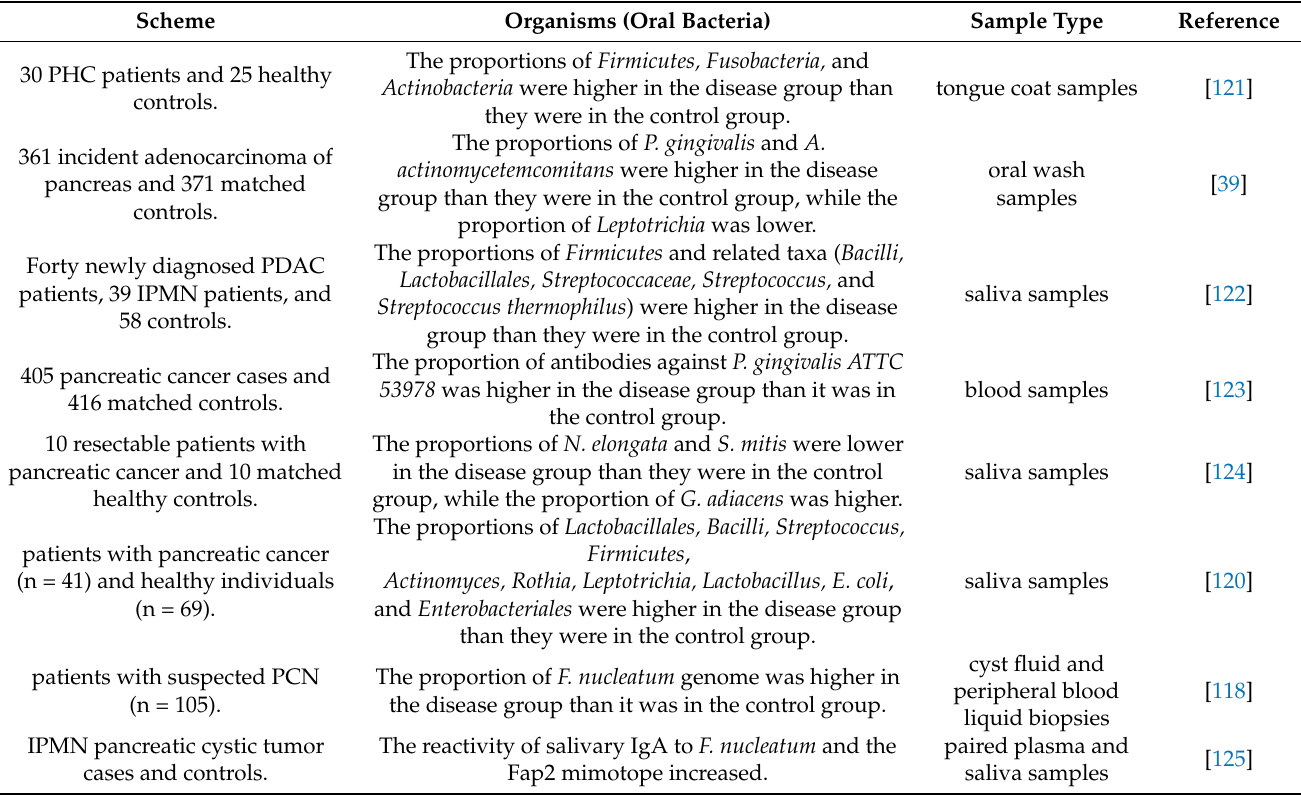
Table 4. Oral organisms associated with pancreatic